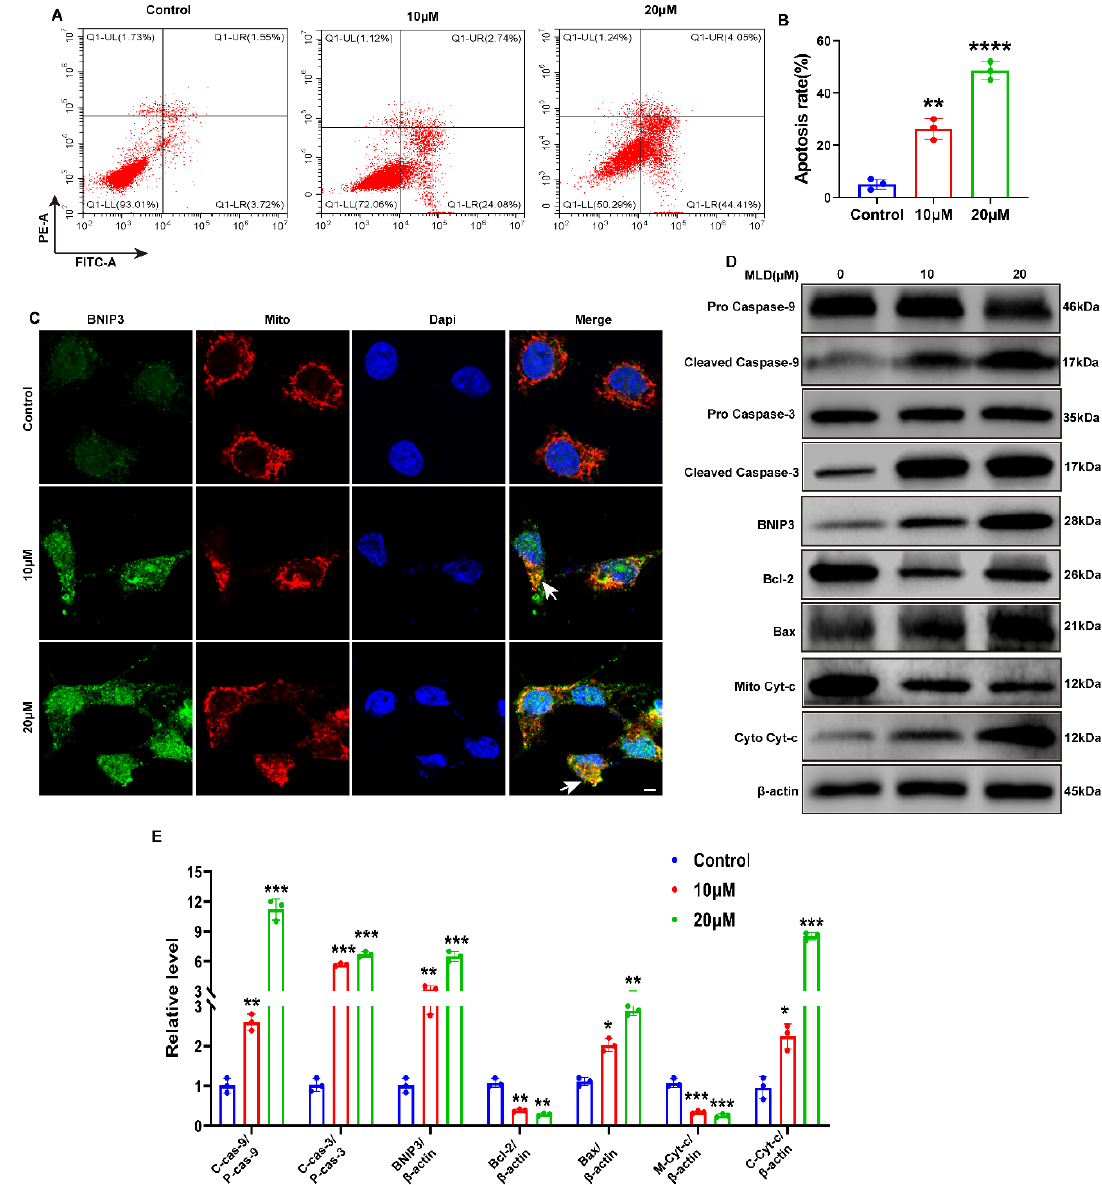
Figure 3. MLD induced the apoptosis of HepG2 cells by promoting the expression of BNIP3. ( A ) MLD induced apoptosis, as detected by Annexin V-FITC/PI double staining assay. ( B ) Quantitative analysis of the apoptosis. ( C ) The protein level of BNIP3 was detected by immunofluorescence. Scale bars: 50 μ m. Arrow: the colocalization of BNIP3 and mitochondria. ( D ) Levels of the pro-caspase-9, cleaved caspase-9, pro-caspase-3, cleaved caspase-3, BNIP3, Bcl-2, Bax, Mito Cyt-c, and Cyto Cyt-c proteins in the different groups were analyzed by Western blotting. ( E ) The quantitative analysis of relative protein levels. The results are representative of three independent experiments and are expressed as the mean ± SD. * p < 0.05, ** p < 0.01, *** p < 0.001, and **** p < 0.0001 compared with the control group.